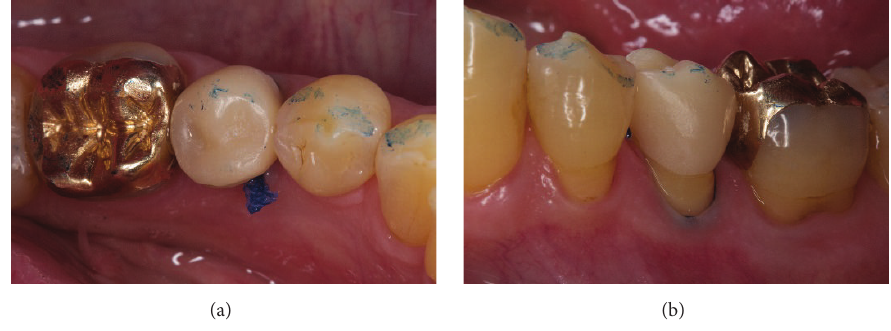
Figure 8: Try-in of the prepolished partial crown.